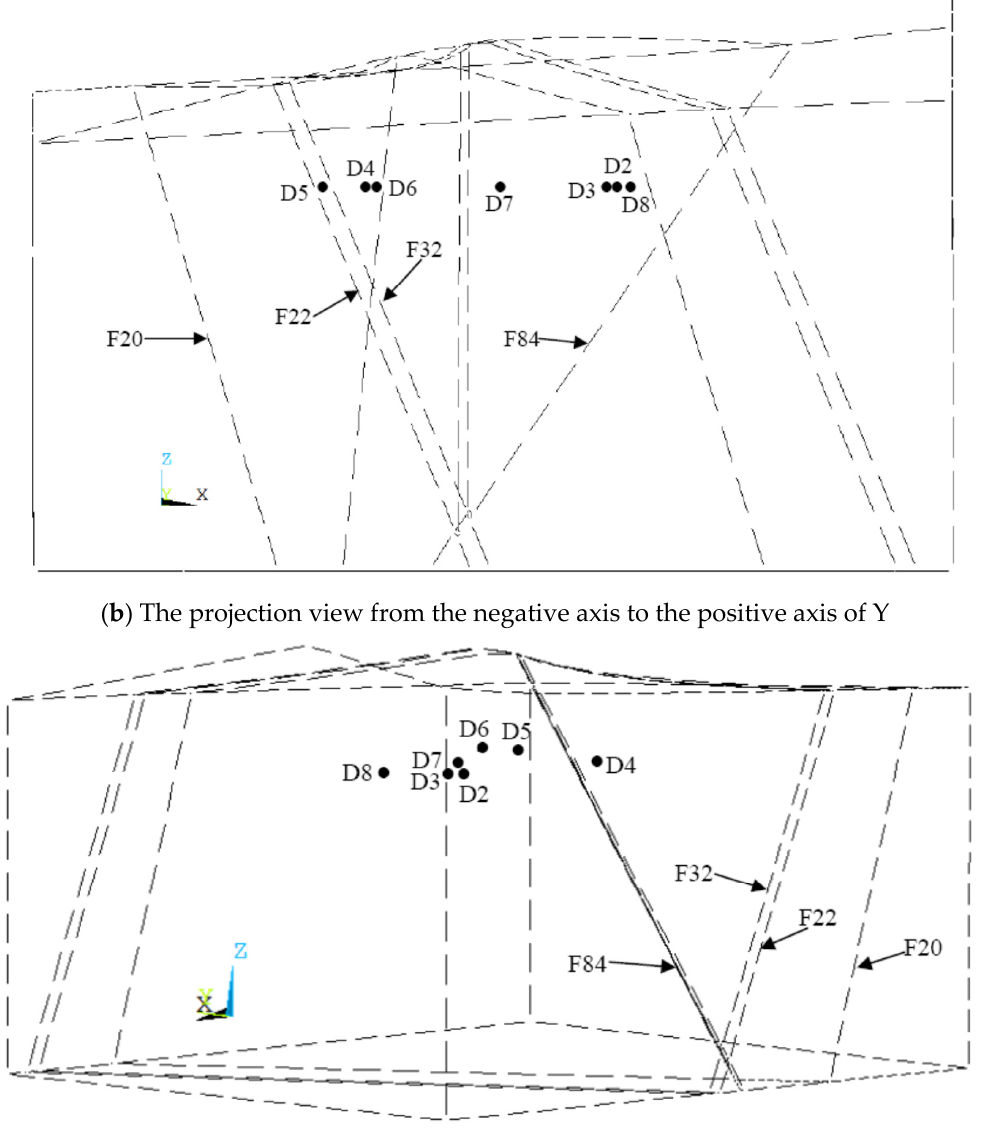
( c ) The relative spatial locations among the test points and the structure plane